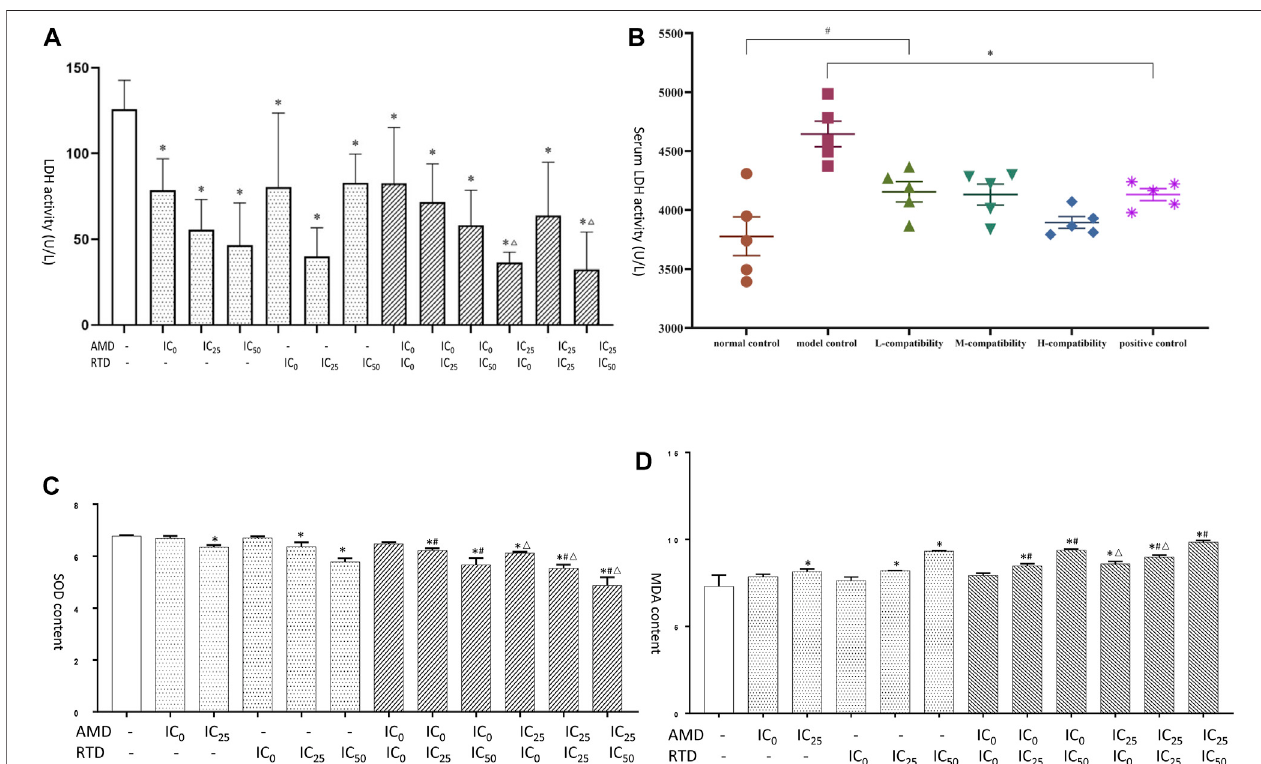
FIGURE 8 | AMD, RTD, and their compatibility affect LDH, SOD, and MDA. (A) Effects of AMD, RTD, and their compatibility on LDH activity of A375 cells. (C – D) EffectsofAMD,RTD,andtheircompatibilityonSOD (C) andMDA (D) contentofA375cells. n =3. p p < 0.05,comparedwiththecontrolgroup. # p < 0.05,comparedwith the corresponding AMD group. △ p < 0.05, compared with the corresponding RTD group. (B) Effects of serum of different mice on LDH activity. n = 5. p p < 0.05, compared with MCG. # p < 0.05, compared with